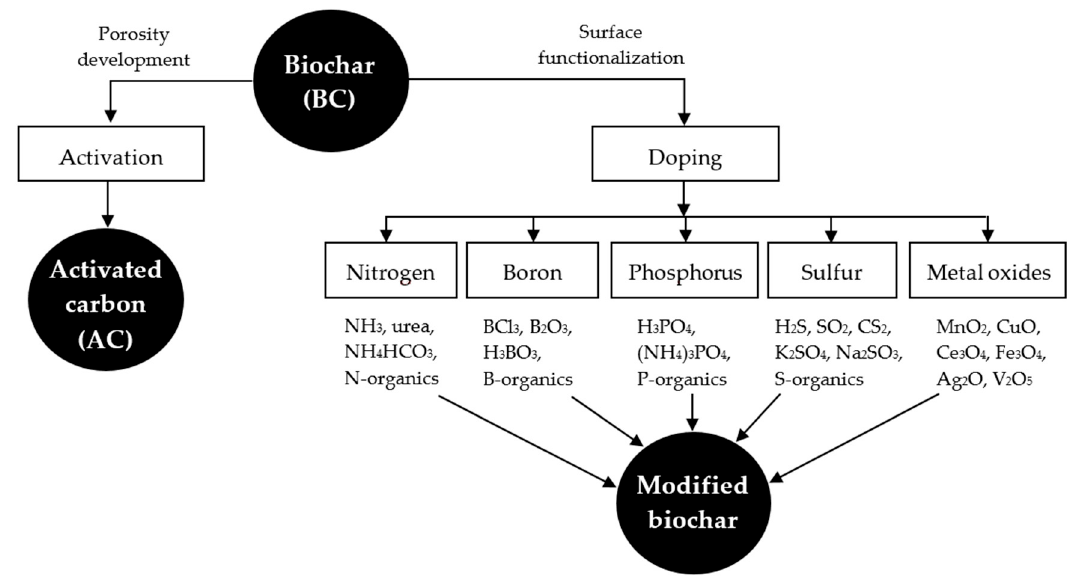
Figure 5. Biochar’s modification to improve the adsorption capacity (adapted from [68], with permission from Elsevier, 2017).